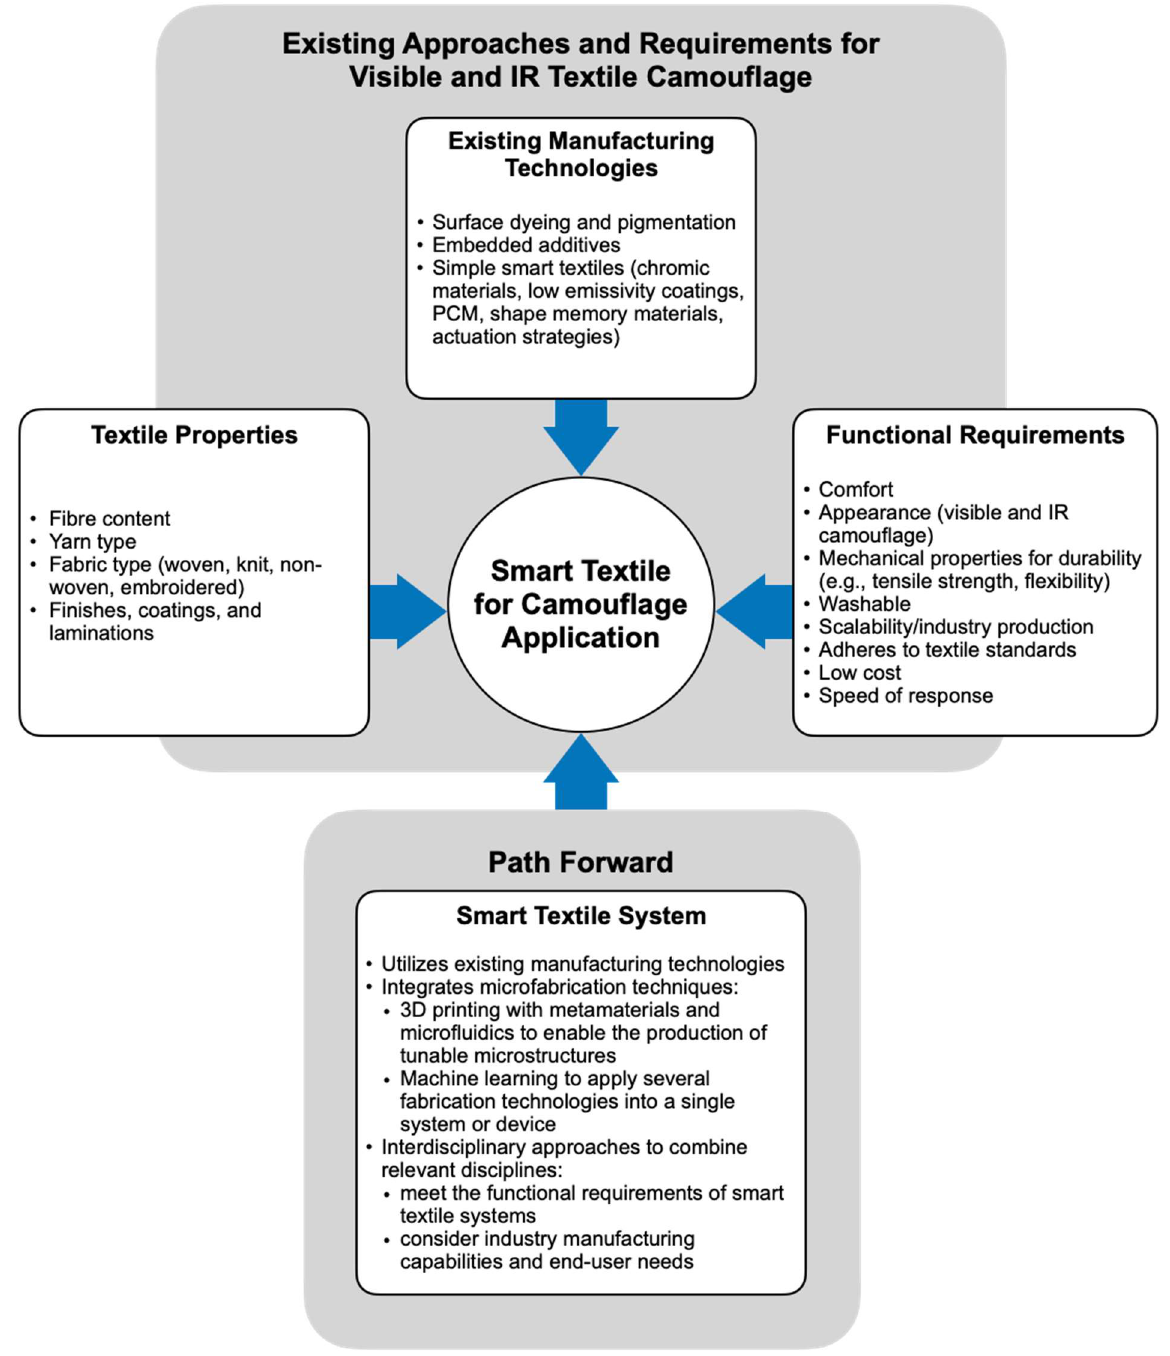
Figure 12. Summary of textile properties, existing manufacturing technologies, and functional requirements for visible and IR smart textile camouflage and the proposed path forward for a smart textile system using existing manufacturing technologies along with microfabrication techniques and interdisciplinary approaches.